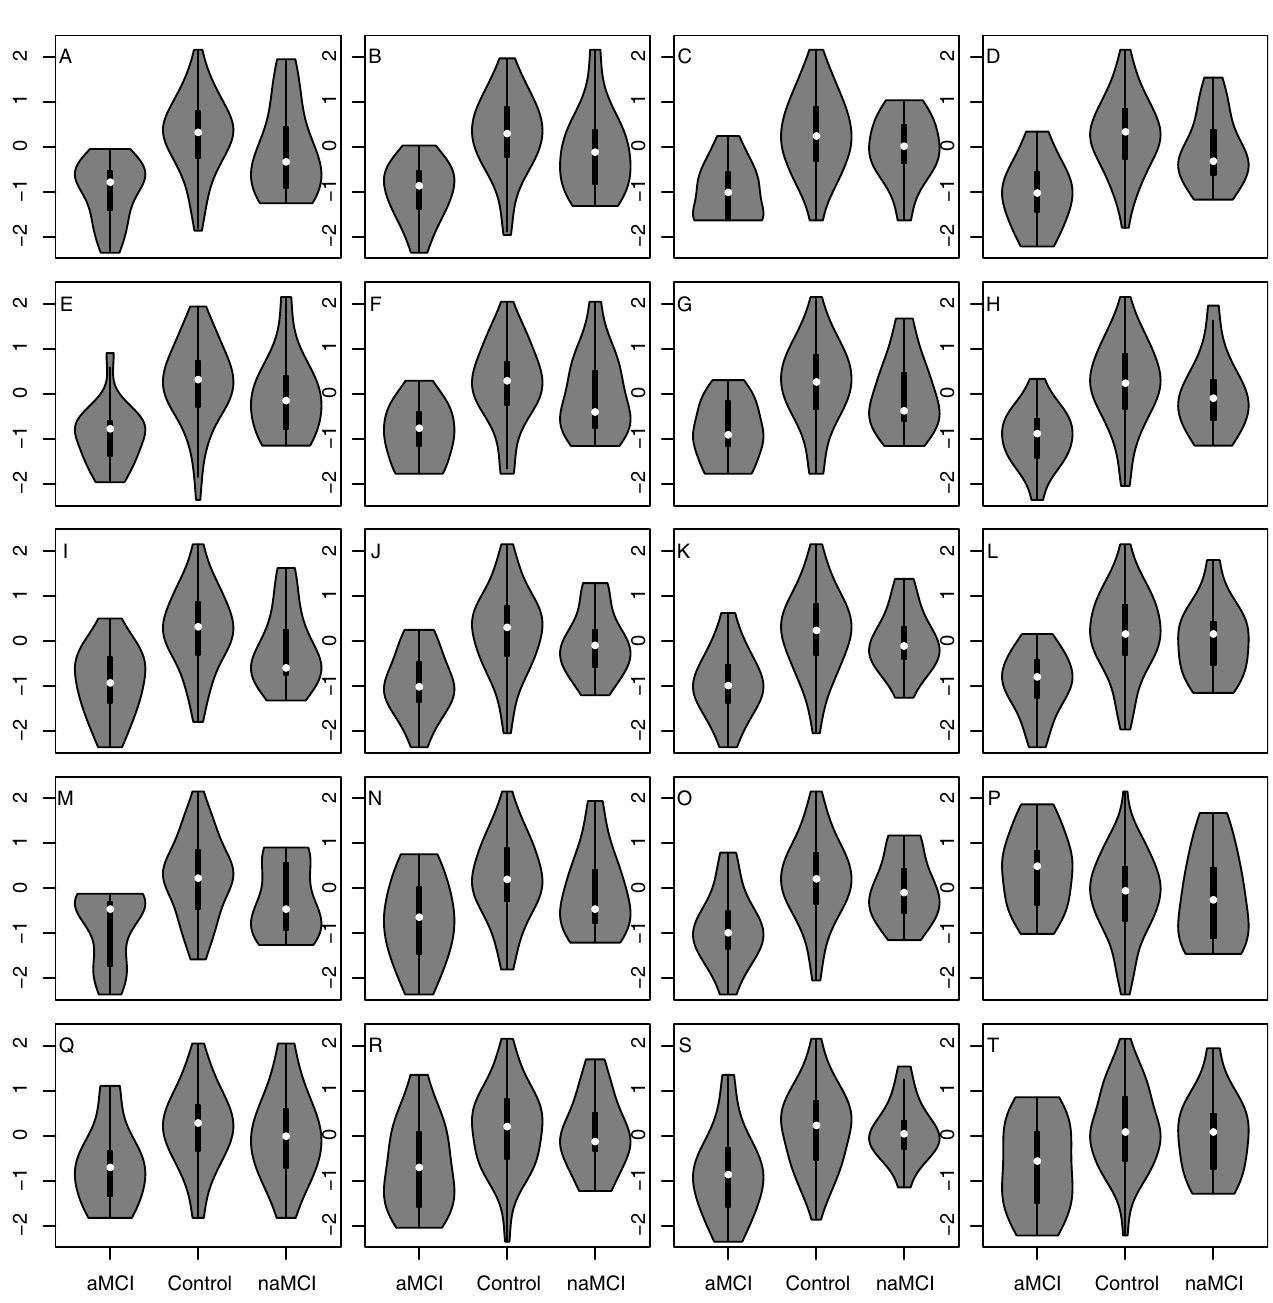
Fig 1. The 2018 speech or language features from Table 2 are displayed with violin and embedded box plots to show the distribution of these features in the three study cohorts: aMCI, naMCI, and Healthy Control. These features have p-values below 0.005 for association with membership in the aMCI or HC cohorts, as determined by logistic regression with adjustment for age and gender. The plots are in the same alphanumeric order as the rows in Table 2, with panel A showing the distribution across cohorts of values for Count of DISTINCT RELATED content units, and subsequent panels for features with increasing p-values. The corresponding p-values for the association of features with aMCI versus HC cohort status are in Table 1. No features had false discovery rates below 1.0 for association with naMCI versus HC cohort status. A: Count of DISTINCT RELATED content units. B: Count of RELATED content units. C: Count of indefinite articles. D: Count of prepositions. E: Count of nouns. F: Both Sides Total Content Units DISTINCT. G: Both Sides Total Content Units. H: Count of ALL content units. I: Count of content units on RIGHT side of picture. J: Count of Syllables. K: Count of words. L: Count of ALL DISTINCT content units. M: Count of DISTINCT content units on RIGHT side of picture. N: Count of sentences. O: Count of phrases. P: Acoustics standard deviation of F0. Q: Count of complete sentences. R: Count of content units on LEFT side of picture. S: Count of all function words. T: Count of DISTINCT content units on Left side of